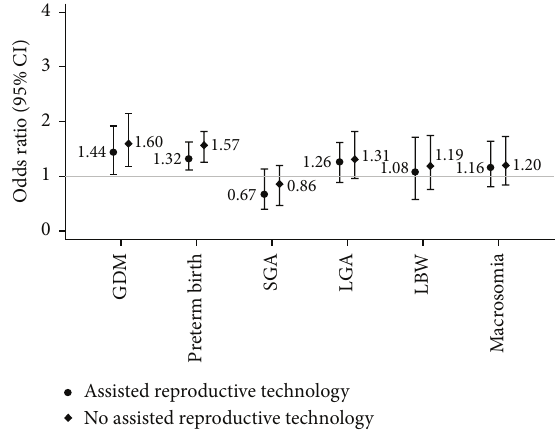
Figure 1: Odds ratios of gestational diabetes mellitus (GDM) and adverse birth outcomes in women with and without polycystic ovary syndrome (PCOS) undergoing assisted reproductive tech- nology (adjusted for maternal age at birth, parity, education, and prepregnancy body mass